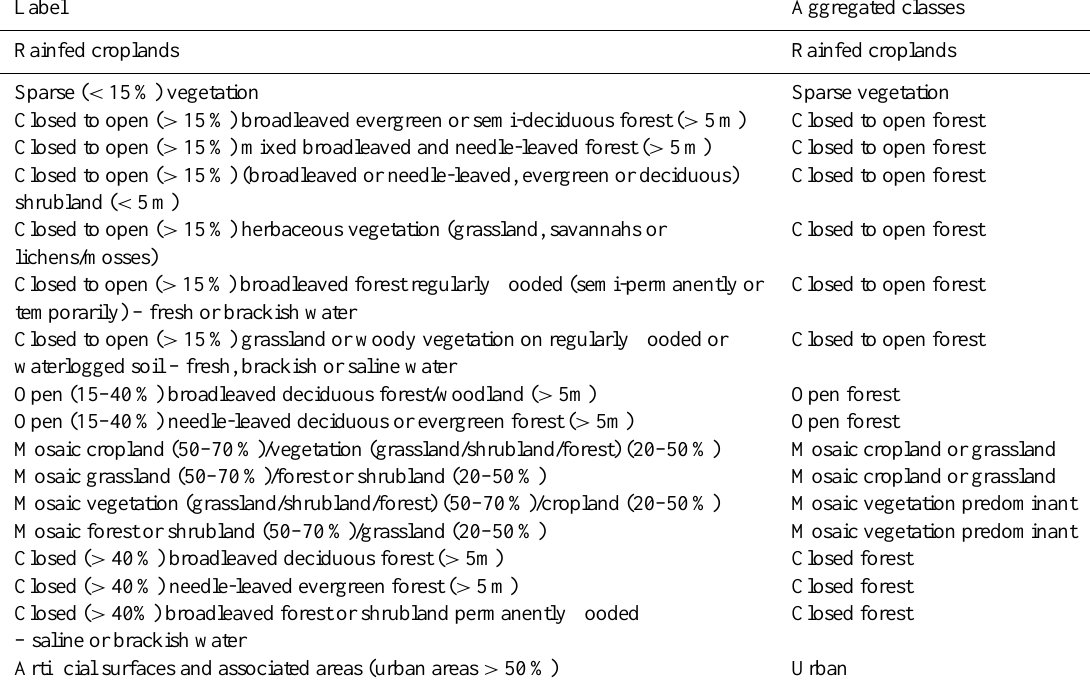
Table A1. Studied land cover types from GlobCover (2009) aggregated into broader categorical classes by type and vegetation